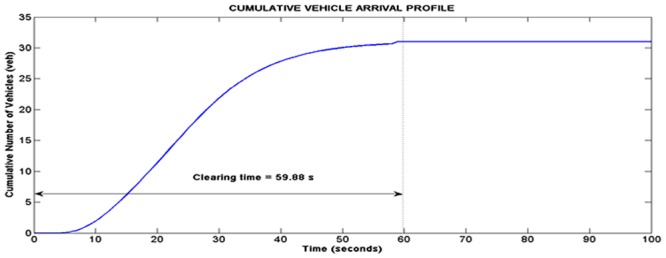
Arrival profile of platoon A.